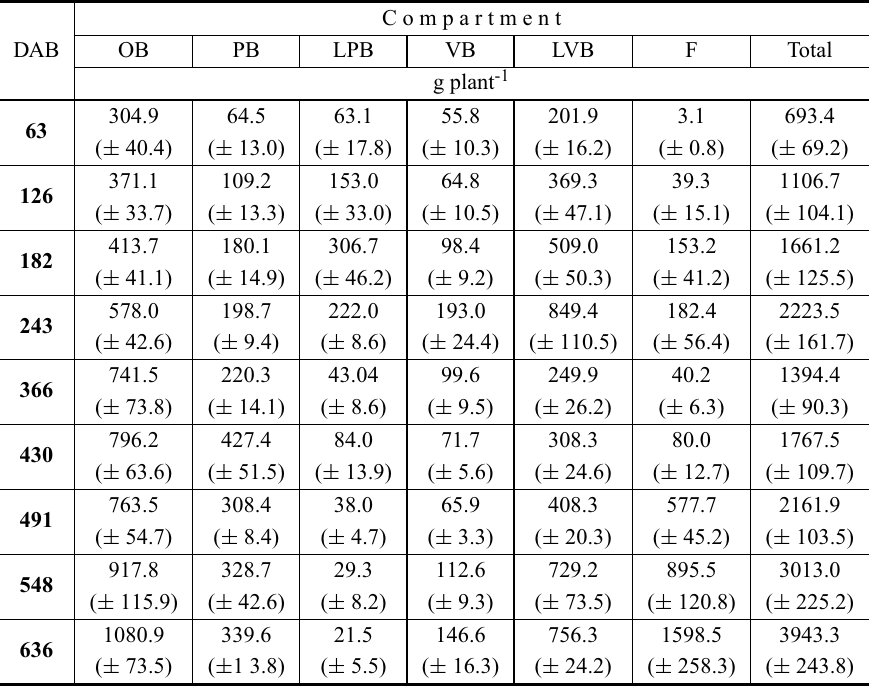
Means and standard errors (s m ) of dry matter yield of the different compartments of the coffee plant shoot as a function of time (DAB = days after beginning, starting Sept 1,